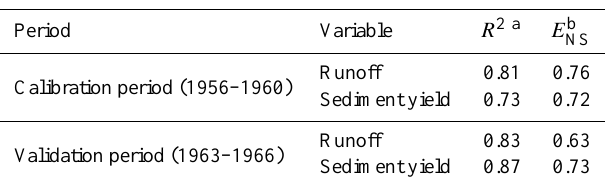
Table 3. The modeling efficiencies of the reference period (1956– 1966).